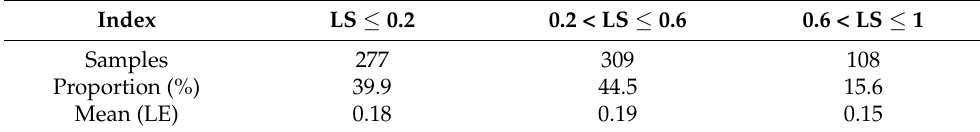
Table 5. Cross statistical analysis of LE and